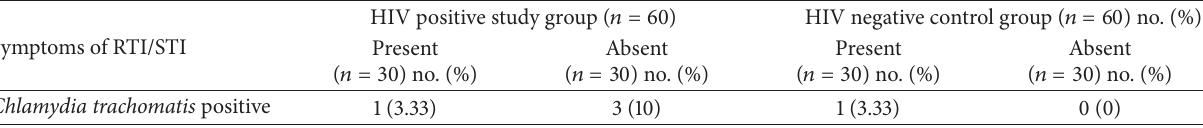
Table 5: Correlation between symptoms of RTI/STI and CTI.